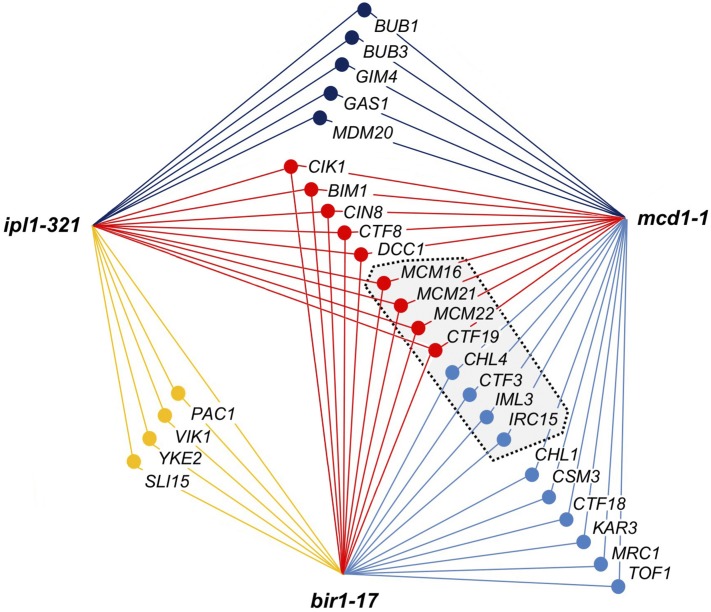
Comparison of the strong negative genetic interactors of ipl1-321, bir1-17, and mcd1-1 revealed by SGA analysis. Genes showing synthetic lethality or strong negative genetic interaction with two or more of ipl1-321, bir1-17, or mcd1-1 are connected to the relevant query mutations by lines that are color-coded according to the number of shared interactions as follows: yellow, negative genetic interactors shared by ipl1-321 and bir1-17; dark blue, negative genetic interactors shared by ipl1-321 and mcd1-1; light blue, negative genetic interactors shared by bir1-17 and mcd1-1; and red, negative genetic interactors shared by all three query genes. The gray box with dashed outline encloses genes encoding components of the Ctf19 complex. Strong negative genetic interactors shown in the diagram were defined as follows: ipl1-321, all genes identified by Ng et al. (2009) as ipl1-321 negative genetic interactors together with additional genes listed in SGD (Cherry et al. 2012, queried December 2016); mcd1-1, all genes identified by Ng et al. (2009) or present in the DRYGIN database (Koh et al. 2010, queried December 2016) as mcd1-1 negative genetic interactors, together with additional genes listed in SGD (Cherry et al. 2012, queried December 2016); bir1-17, all strong negative enhancers identified in this work at any of the three screening temperatures that were shared with at least one of the other two mutations (ipl1-321 or mcd1-1). Note that we find that deletion of CTF19 is synthetic lethal with ipl1-321 as shown (100% inviability of 25 ctf19::KanMX ipl1-321 spores in 31 tetrads from a W303 background ctf19::KanMX × ipl1-321 cross where single ctf19::KanMX and ipl1-321 segregants showed 100% and >97% viability, respectively). IRC15 is included within the Ctf19 complex because its knockout also affects CTF19: see Confirmation of the negative genetic interactions between bir1-17 and the Ctf19, Ctf8-Ctf18-Dcc1 and Csm3-Mrc1-Tof1 complexes in W303 for details.